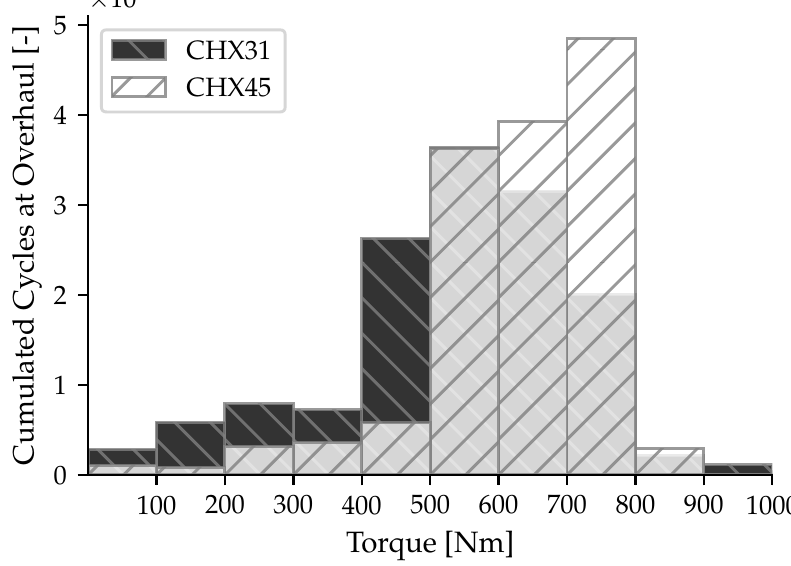
Figure 11. Torque histogram of the scaled flights of CHX31 and CHX45 .